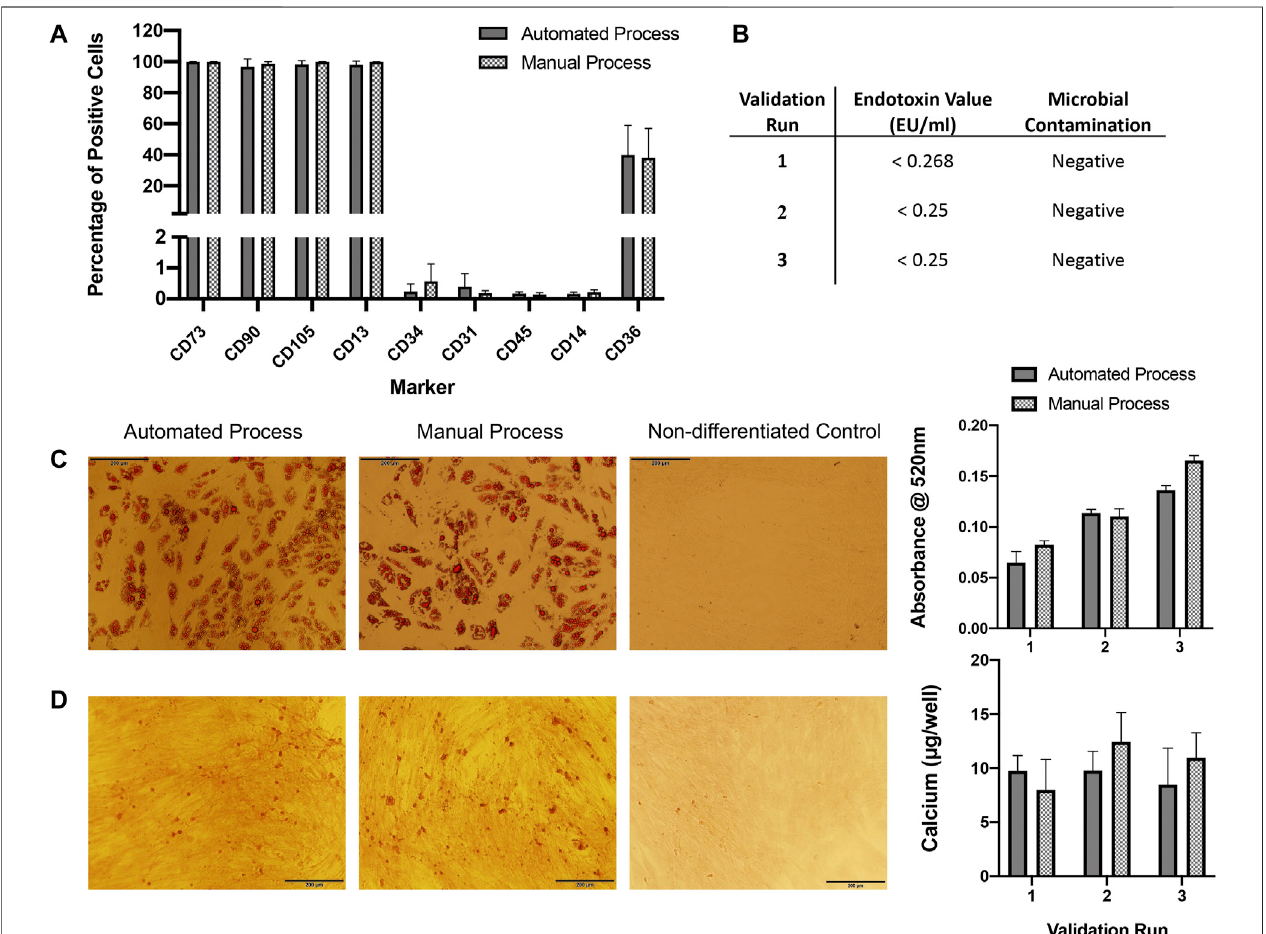
FIGURE 4 | QC analysis. (A) Flow cytometry immunophenotyping of ASCs expanded in automated or manual processes over three validation runs ( n = 3). Expressionisshownaspercentagepositivecells.Resultsareexpressedasmean±SEM. (B) ASCsexpandedinbothautomatedandmanualculturestestednegativefor microbial contamination. Endotoxin concentration was assessed in automated cultures only and was < 1 EU/ml for all. (C) ASCs expanded using the automated and manual processes were capable of undergoing adipogenic differentiation for all three validation runs, representative images of oil red O staining in automated and manual process test samples and a control (non-differentiated) sample are shown. Semi-quanti fi cation of oil red O staining by measurement of absorbance at 520 nm wasperformed, resultsareexpressedasmean±SEM.Magni fi cation=×10,scalebar=200 µm. (D) ASCsexpandedusingtheautomated andmanual